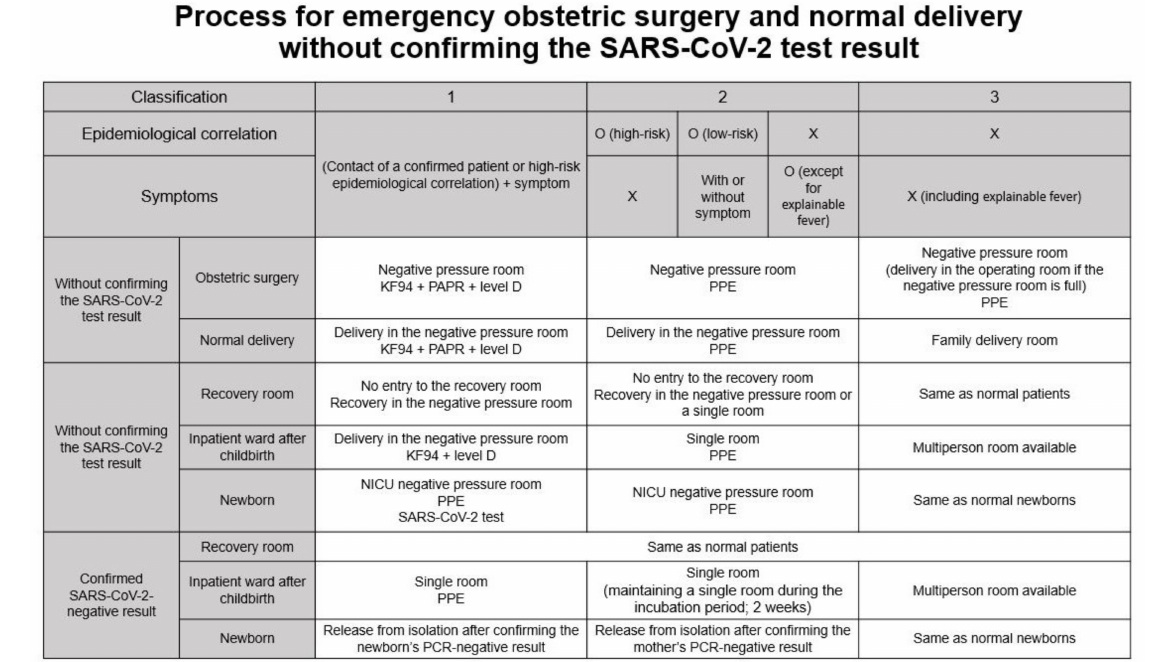
Figure 2. Protocol for emergency obstetric surgery and normal delivery without confirmation of SARS-CoV-2 test result. PPE comprises a KF94 mask, long-sleeve gown, gloves, and goggles. See Figure 3 for the types of PPE used at the Asan Medical Center (AMC). PAPR: powered air-purifying respirator; PPE: personal protective equipment (KF94 mask + long-sleeve gown + gloves + goggles); SARS-CoV-2: severe acute respiratory syndrome coronavirus 2; NICU: neonatal intensive care unit.